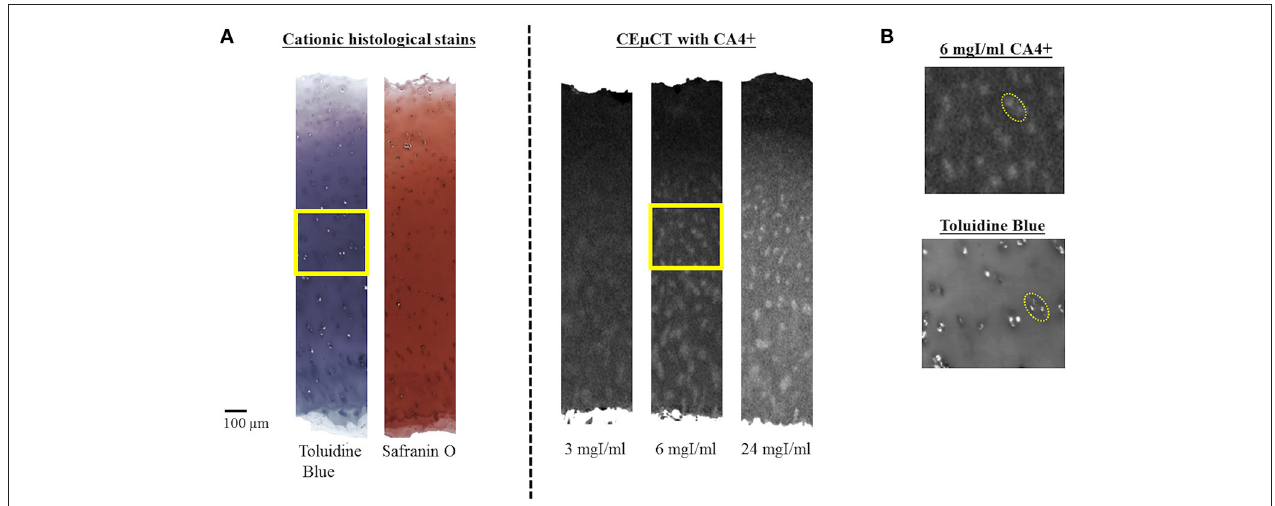
FIGURE 2 | (A) Comparison of histological cationic stains to CE µ CT with different concentrations of CA4 + (at 48h). Safranin O and Toluidine Blue indicate similar GAG depth-wise distribution as in CA4 + stained AC by having stronger staining deeper on the tissue compared to the surface. Additionally, the difference in dynamic depth-wise stainability of GAG distribution can be observed between different histological stains as well as between the different concentrations of CA4 + . Scalebar on the left corner 100 µ m. Areas restricted by yellow square magnified in (B) . (B) Magnification of Toluidine Blue stain (below) compared to 6mgI/ml concentration of CA4 + , shows that the CA4 + accumulation exceeds the cell areas according to the GAG content around the chondrons (yellow dotted line circle, scaled to same size in both CA4 + and Toluidine Blue image).